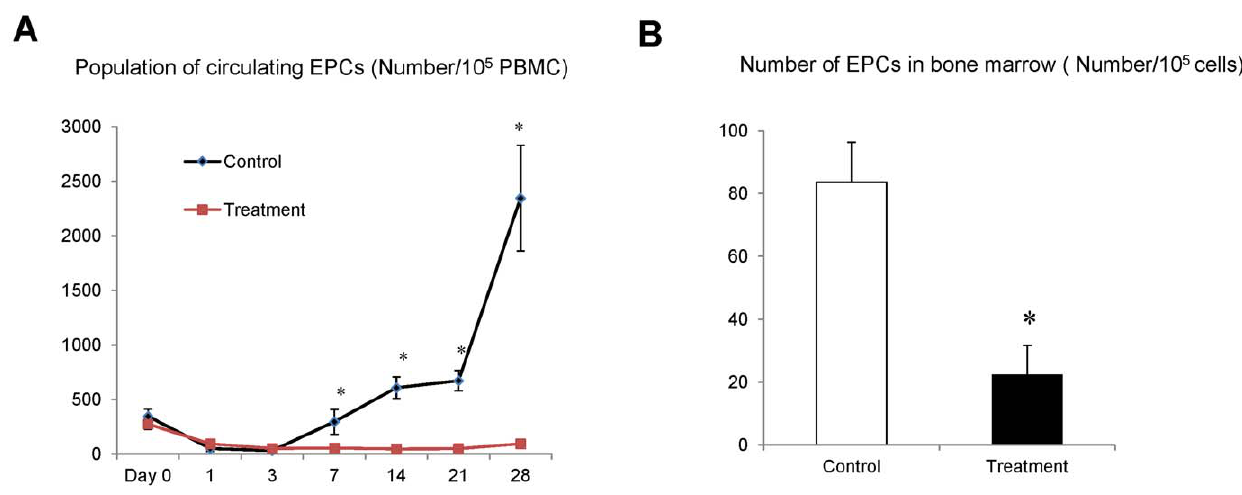
Figure 2. Comparison of circulating EPCs and bone marrow EPCs by Flow Cytometry. (A) The number of circulating EPCs at different time points after the major hepatectomy and partial I/R injury. (B) The number of EPCs in bone-marrow was detected by Flow Cytometry at four weeks later after liver resection and I/R injury. Each group contained 16 rats, *P , 0.05 .